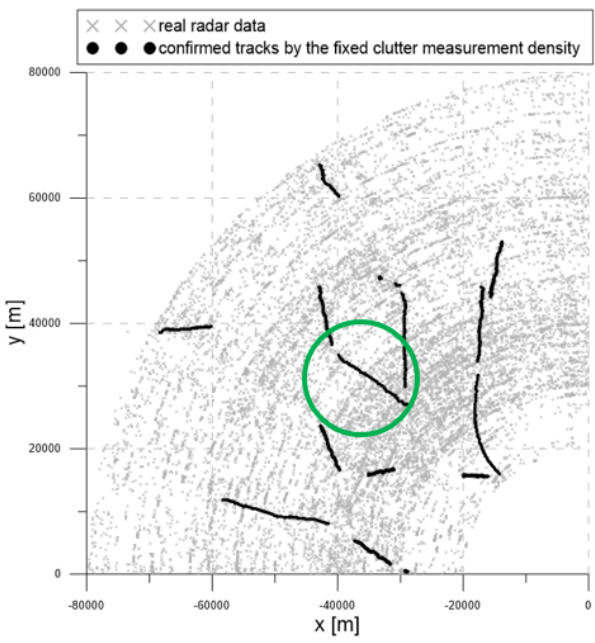
Figure 17. The trajectories of the confirmed tracks by using the fixed clutter measurement density.